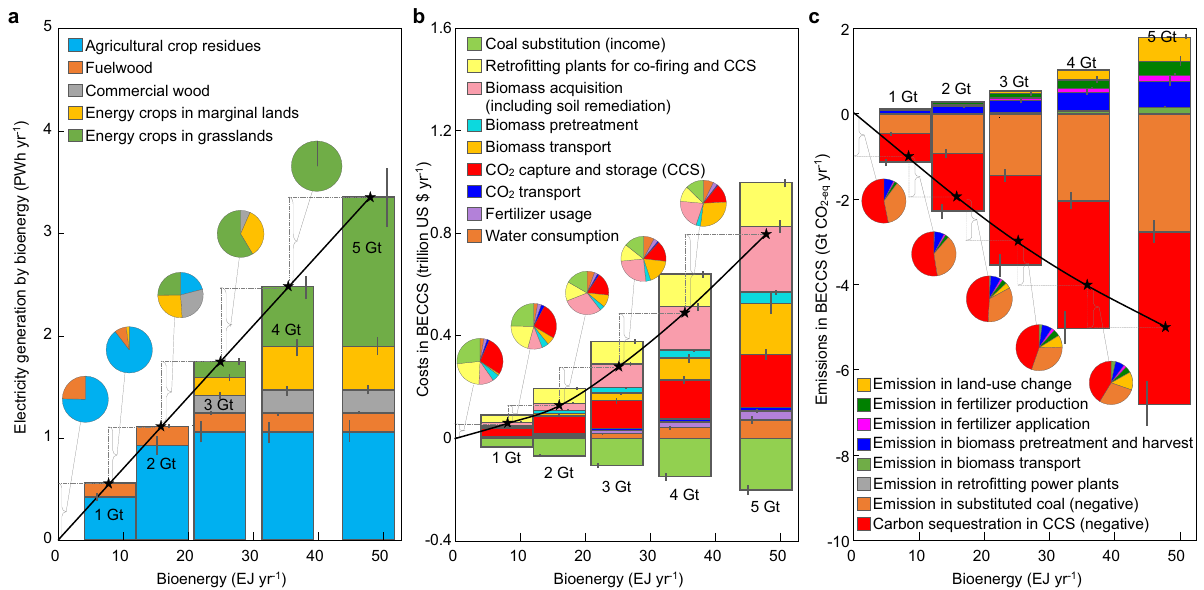
Fig. 4 Composition of biomass feedstocks, economic costs, and carbon emissions by employing BECCS in China. Bioenergy in electricity generation ( a ), economic costs ( b ), and life-cycle emissions ( c ) for BECCS are calculated from the scenario “ B90-2015-PC ” with 90% biomass co- fi ring in pulverized- coal plants. The components of electricity, costs, and emissions as differences between two adjacent bars under net emission reductions of 1, 2, 3, 4, and 5 Gt CO 2-eq year − 1 are shown as pie charts. Uncertainty in the calculated electricity, costs, and emissions to abate 1, 2, 3, 4, and 5 Gt CO 2-eq year − 1 in our Monte Carlo simulations are shown by error bars.